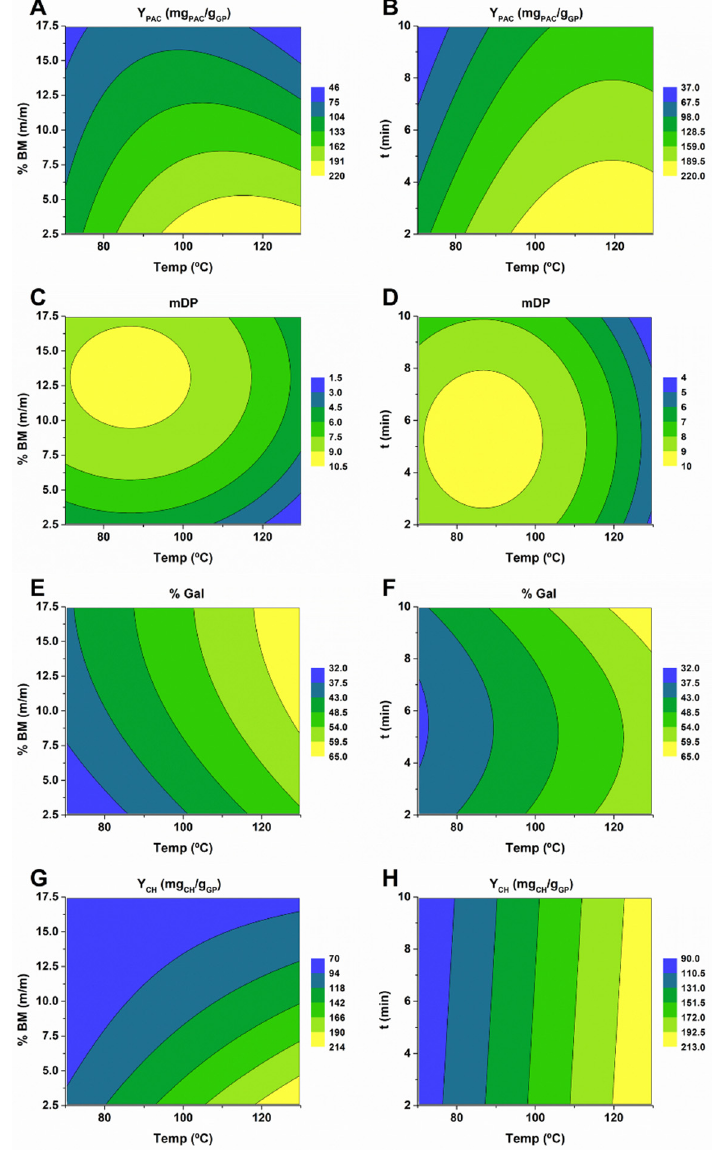
Figure 6. Contour plots obtained for the extraction conditions for the optimization of ChCl:LacA. ( A ) Y PAC for t = 2 min; ( B ) Y PAC for %BM = 2.5%; ( C ) mDP for t = 5.23 min; ( D ) mDP for %BM = 13%; € %Gal for t = 10 min; ( F ) %Gal for %BM = 17.5%; ( G ) Y HC for t = 2 min; ( H ) Y HC for %BM = 2.5 min.